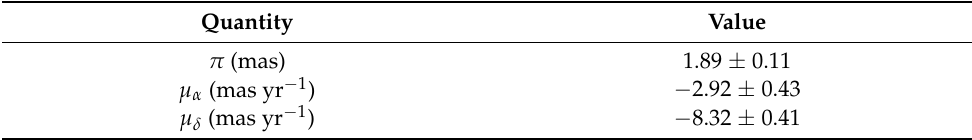
Table 3. The cluster astrometric quantities from the fit to the Gaia